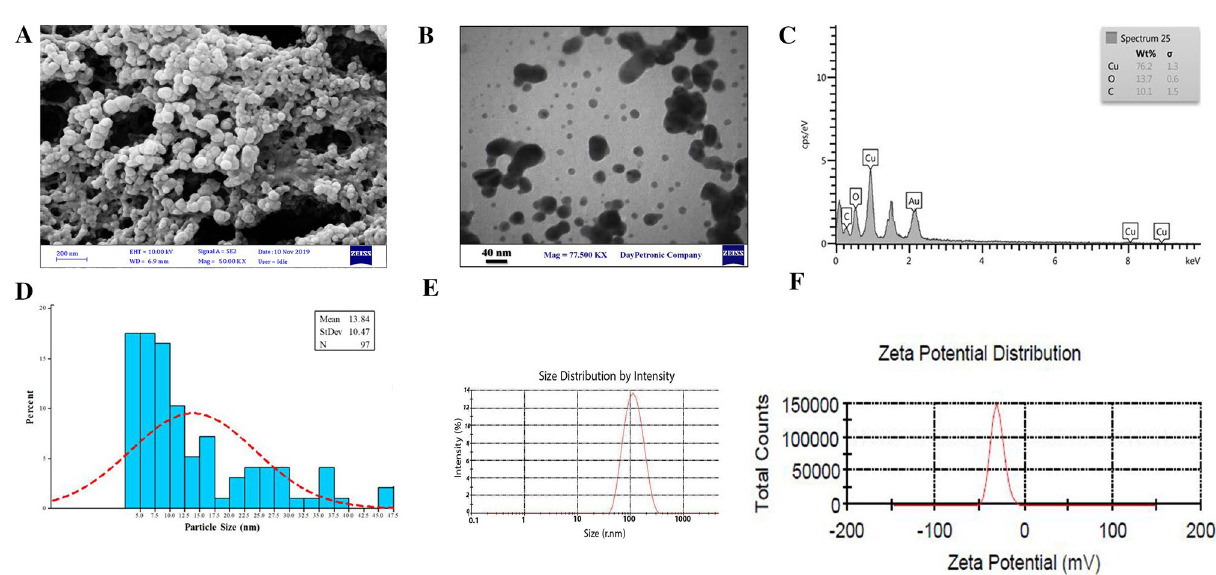
Figure 3. ( A ) FE-SEM, ( B ) TEM, ( C ) EDS, ( D ) Particle size, ( E ) DLS and ( F ) Zeta-potential of BC-CuONPs, Zeta potential and DLS values were obtained after 5 running